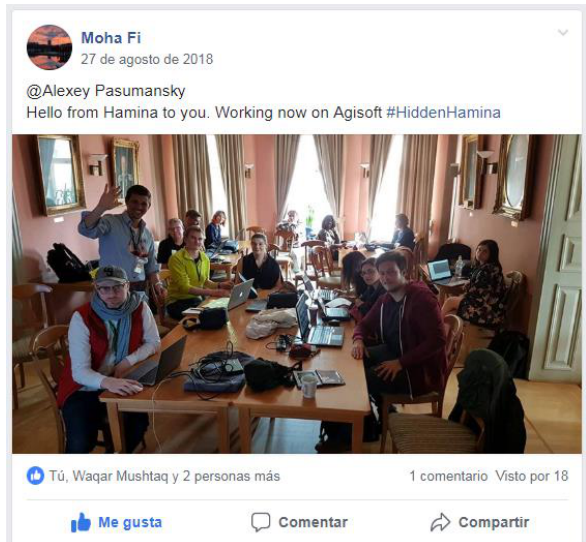
Figure 11. Posted picture on Facebook to our online, posted by student Mohammad Boroojerdi